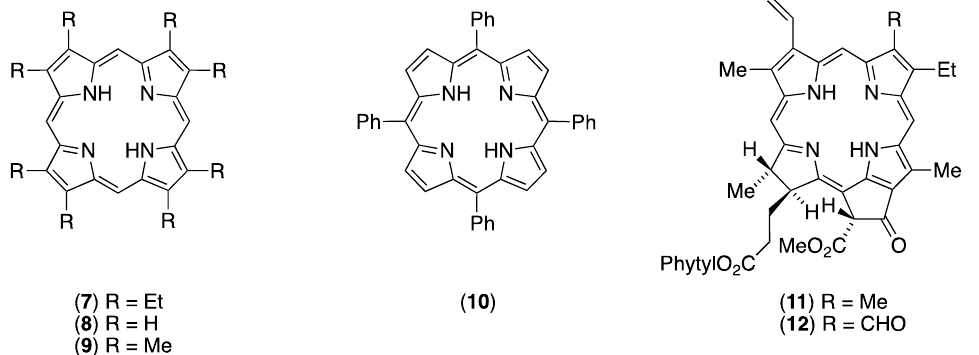
Figure 2. Structures of porphyrins ( 7 – 10 ) and pheophytins-a and -b.